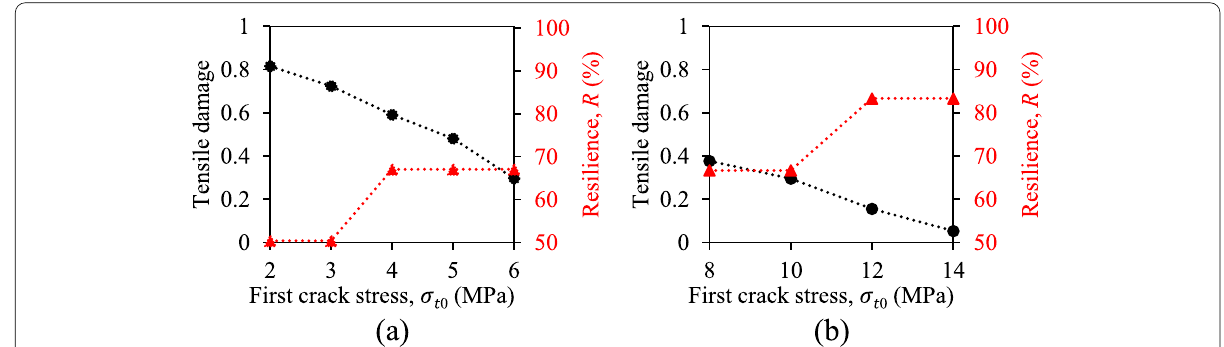
Fig. 12 The effect of the first crack stress on the maximum tensile damage and resilience: a SHCC ( ε tu 0.3% and σ tu 14 =